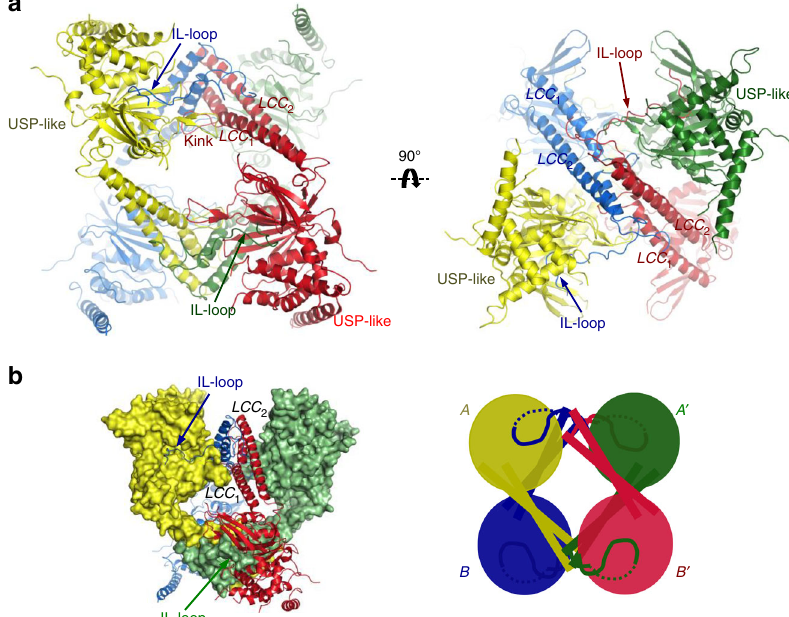
Fig. 3 USP25 is a homotetramer formed by the assembly of two dimers. a Ribbon representation of the USP25 tetramer. Each subunit is represented with a different color. LLC and IL-loop domains are labeled. Different orientations of the USP25 tetramer. b Mixed surface and ribbon representation of the homotetramer structure of USP25. Cartoon image of the tetramer assembly formed by the assembly of two homodimers (A, A ′ homodimer and B, B ′